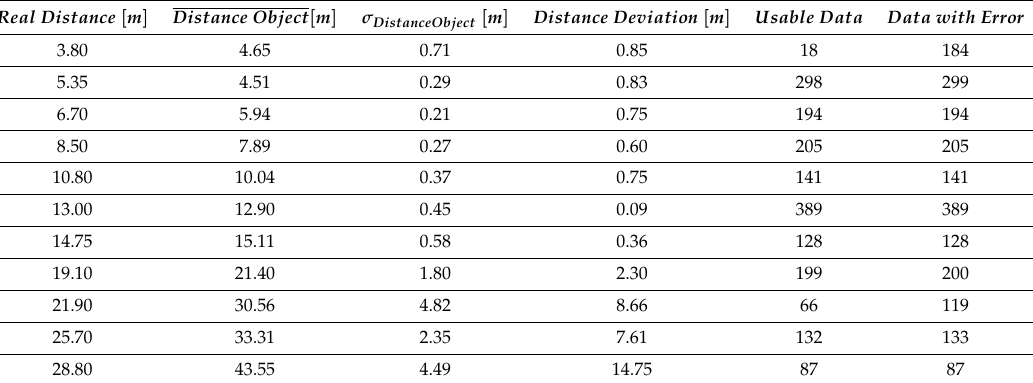
Table 3. Measurement results of the test vehicle Testcar2.